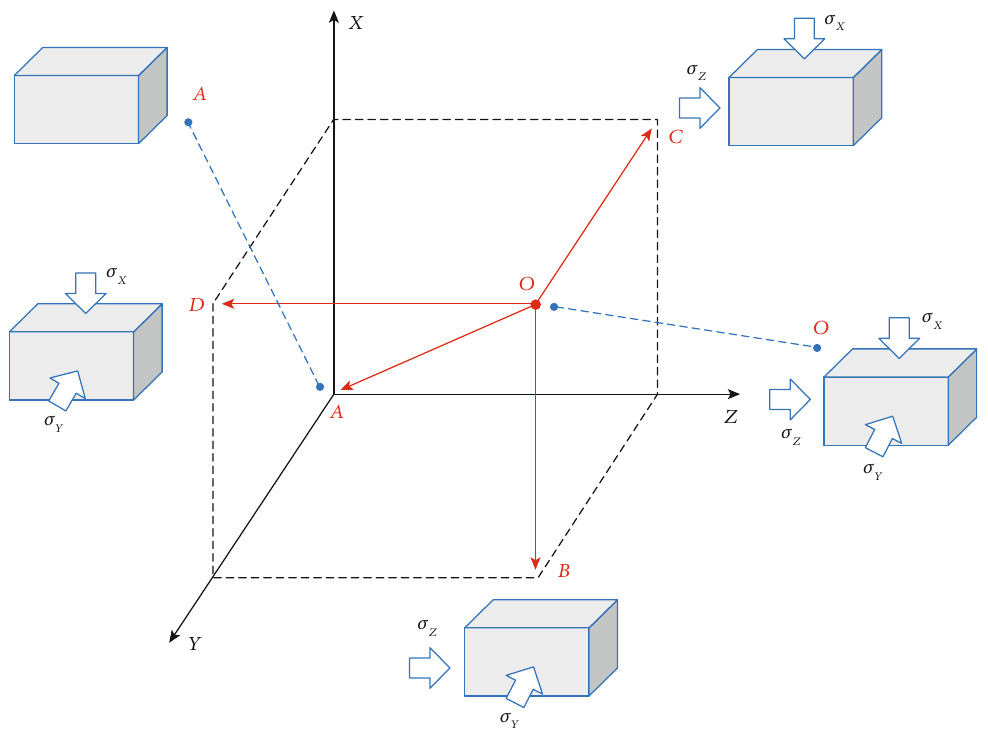
Figure 2: Unloading stress paths of pressure relief gas drainage